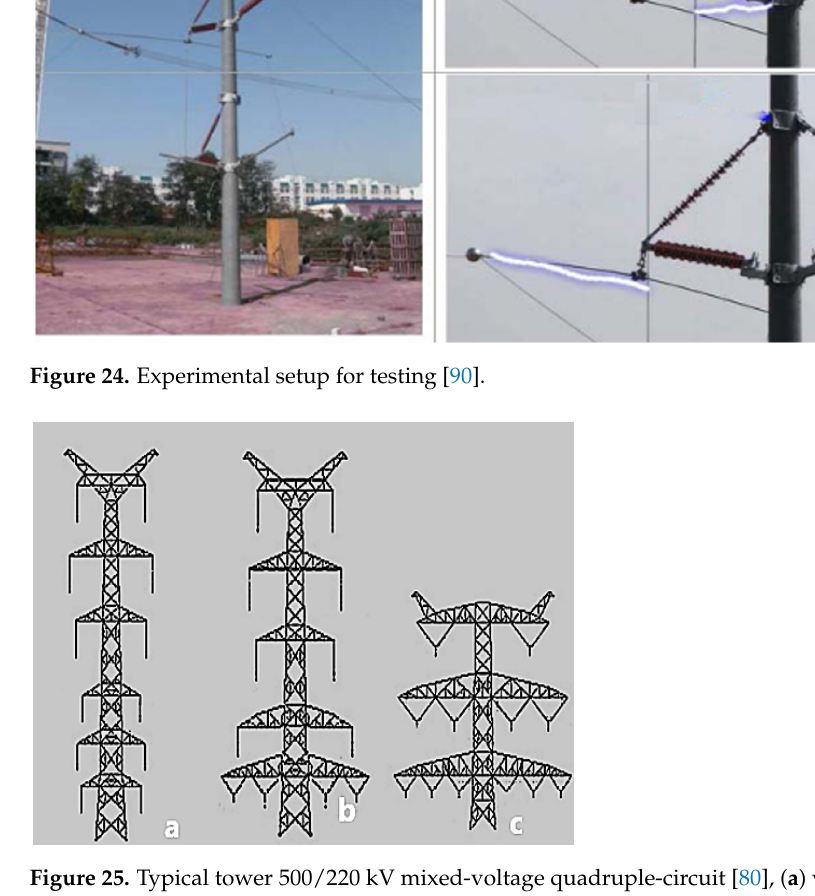
Figure 25. Typical tower 500/220 kV mixed ‐ voltage quadruple ‐ circuit [80], ( a ) vertical tower, ( b ) d ‐ type tower, and ( c ) e ‐ type [80].